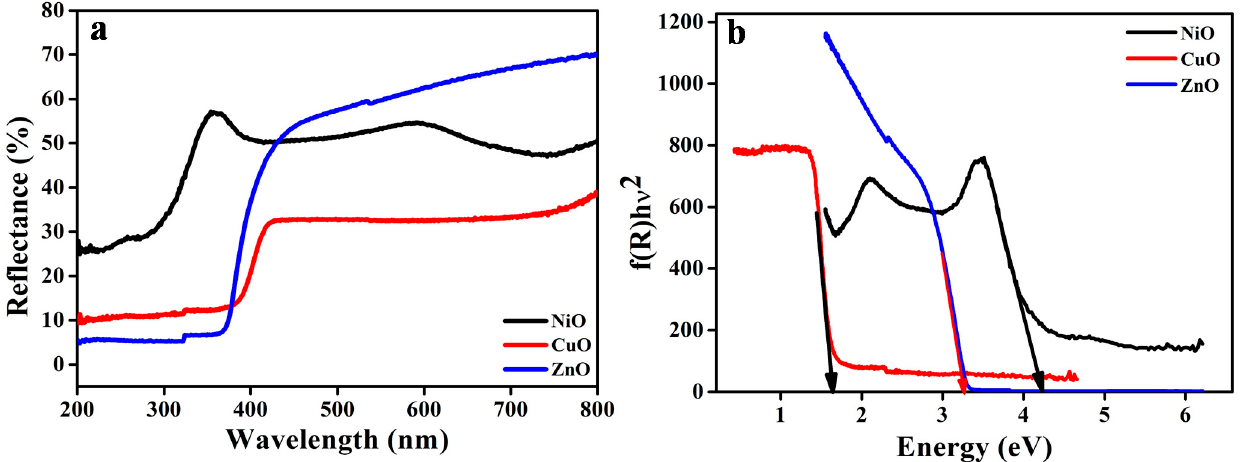
Figure 5. (a). DRS spectra and (b). Energy bandgap of all the MO samples. Figure 5. ( a ) DRS spectra and ( b ) Energy bandgap of all the MO